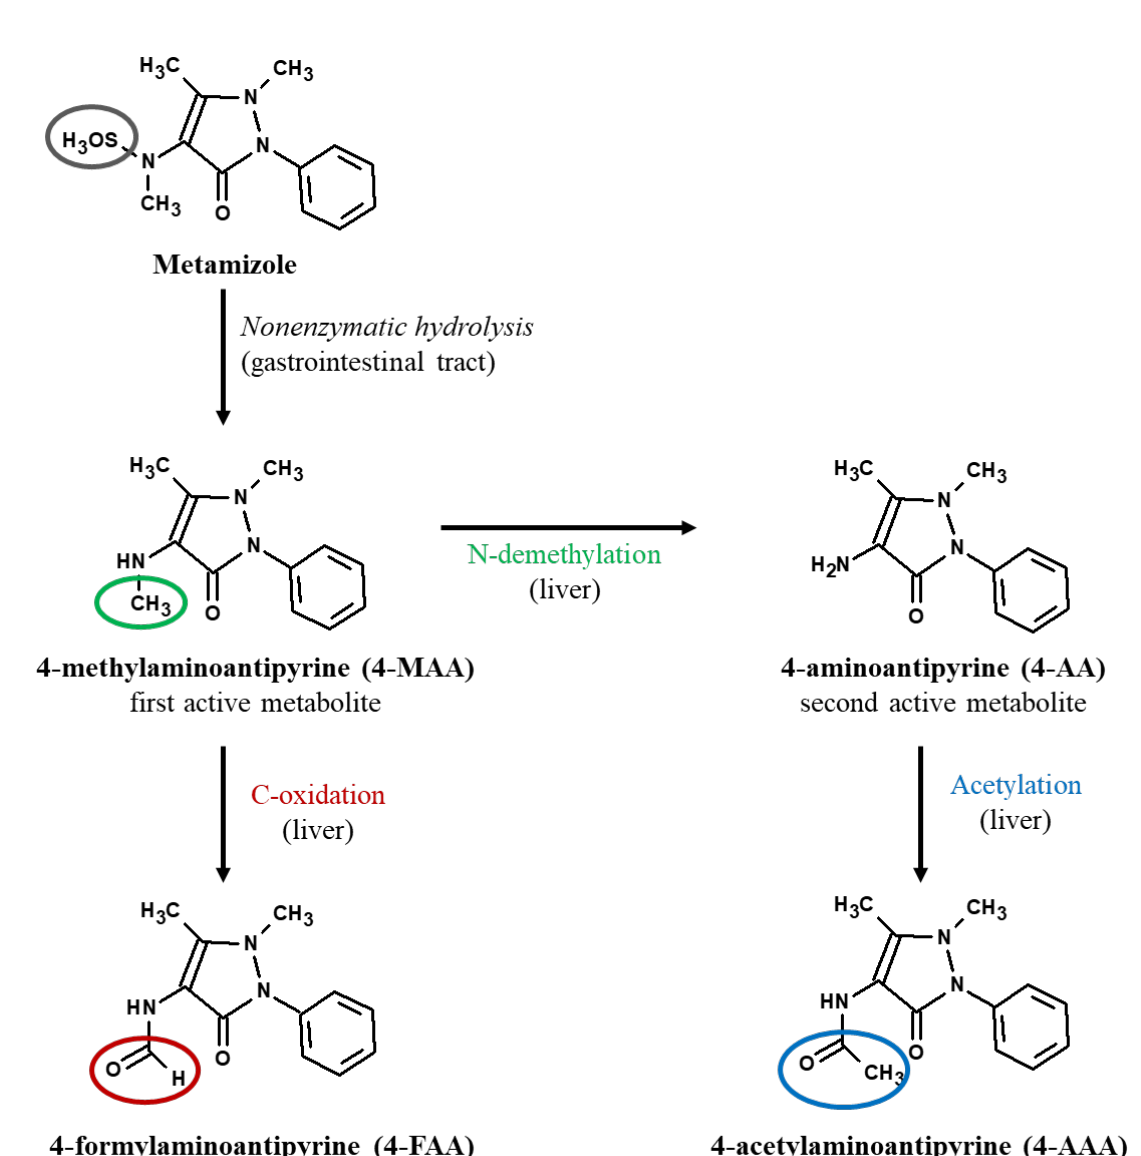
Figure 1. Hepatic metabolism of metamizole (adjusted after Lutz, 2019 [32]).